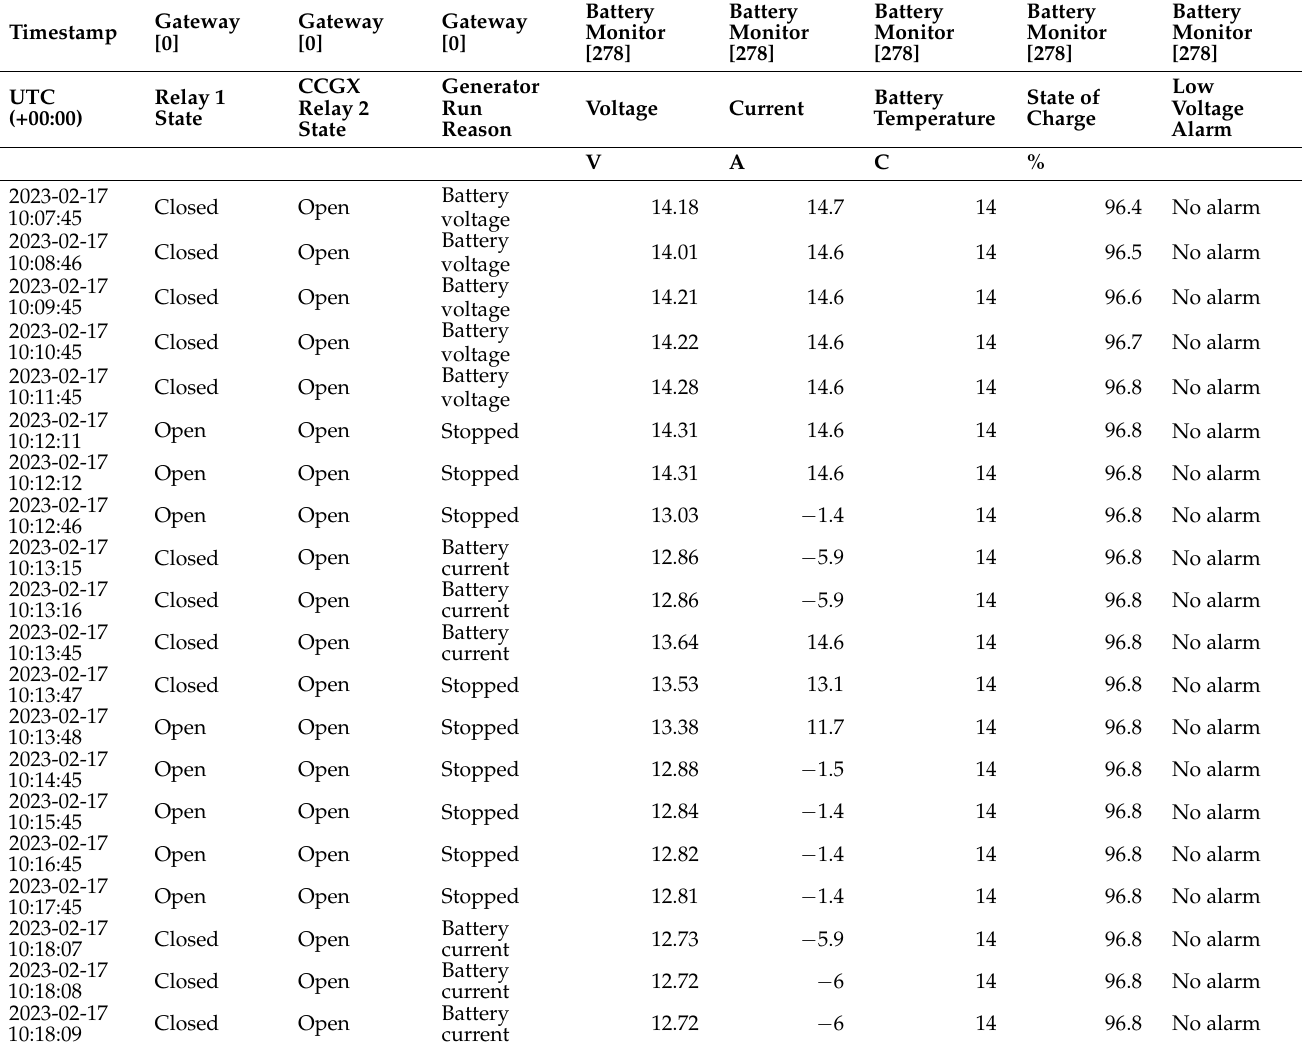
Table 3. Capture 2 in test based on voltage, current, and SOC